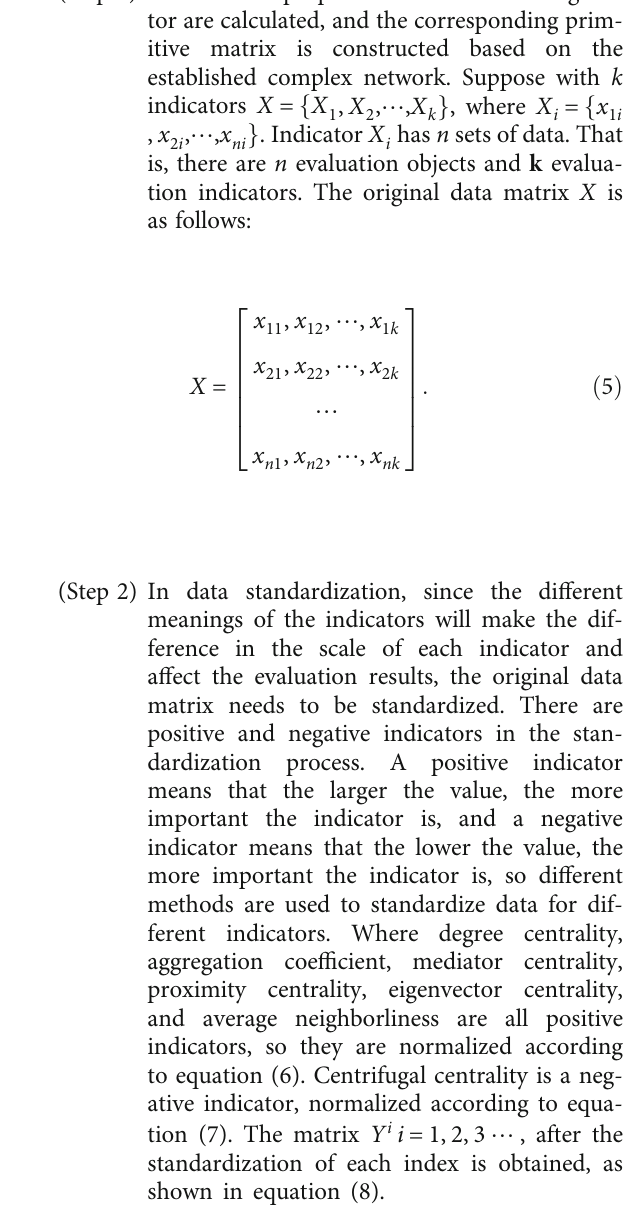
Table 9: Frequent item set L